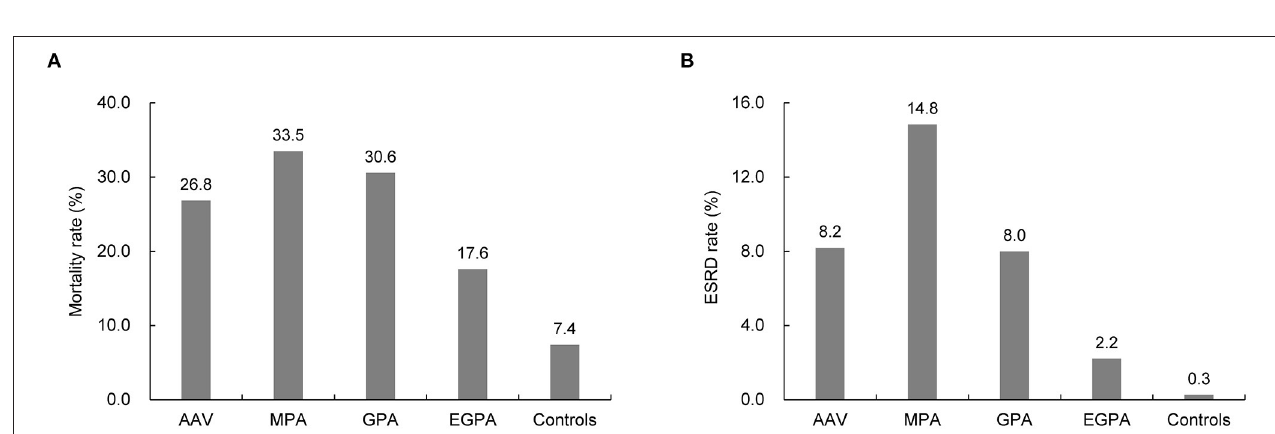
FIGURE 3 | Estimation of annual economic cost in patients with ANCA-associated vasculitis and controls. While the economic cost in healthy controls remained stable during the follow-up period, patients with ANCA-associated vasculitis showed a steep reduction in medical costs in the second year after diagnosis, and remained similar after the third year. ANCA, antineutrophil cytoplasmic antibody; ESRD, end-stage renal disease; MPA, microscopic polyangiitis; GPA, granulomatosis with polyangiitis; EGPA, eosinophilic granulomatosis with polyangiitis.